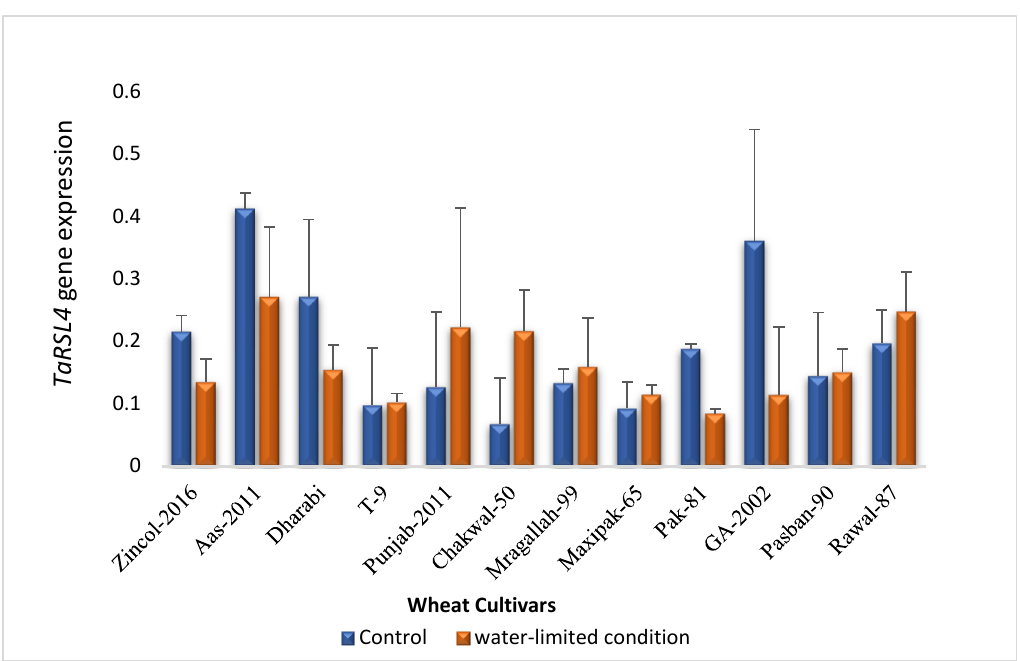
Figure 4. qRT-PCR based relative expression of TaRSL4 in twelve wheat cultivars under control and water-limited conditions.